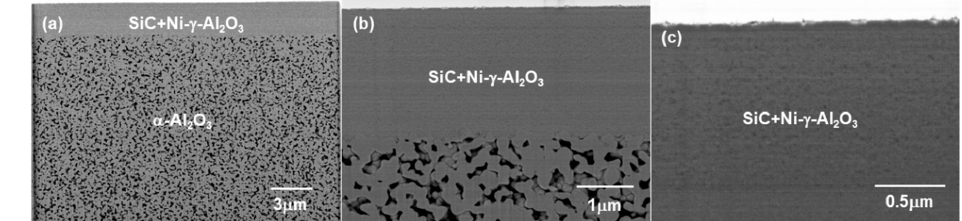
Figure 5 . Cross-sectional backscattered electron images of SiC/Ni- γ -Al 2 O 3 / α -Al 2 O 3 membrane: ( a